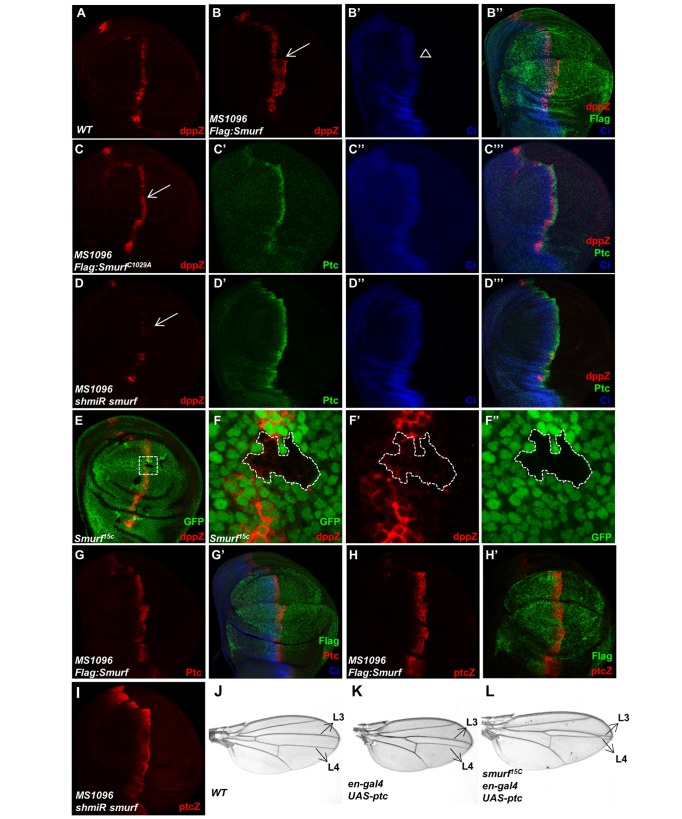
Smurf positively regulates Hh signaling pathway in wing discs.(A) Wild-type (WT) wing discs carrying dpp-LacZ (dppZ) reporter were immunostained with anti-β Gal antibody to show the expression of dppZ (red). (B–B″) Wing discs expressing Flag:Smurf driven by MS1096-gal4 were immunostained to show the expression of dppZ (red), Ci (blue), and Flag (green). (C–C′″) Wing discs expressing Flag:SmurfC1029A driven by MS1096-gal4 were immunostained to show the expression of dppZ (red), Ptc (green), and Ci (blue). (D–D′″) Wing discs expressing shmiR smurf driven by MS1096-gal4 were immunostained to show the expression of dppZ (red), Ptc (green), and Ci (blue). (E and F–F″) Low (E) and high (F–F″) magnification views of a smurf15c clone at A/P boundary. Immunostaining was performed to show the expression of dppZ (red) and GFP (green). Smurf15c clones are recognized by the lack of GFP. (G and G′) Wing discs expressing Flag:Smurf driven by MS1096-gal4 were immunostained with Ptc antibody to show the expression of Ptc (red) and Flag (green). (H and H′) Wing discs expressing Flag:Smurf driven by MS1096-gal4 were immunostained to show the expression of ptcZ (red) and Flag (green). (I) Wing discs expressing shmiR smurf driven by MS1096-gal4 were immunostained to show the expression of ptcZ (red). (J–L) comparison of adult wing phenotype from wild-type flies (J), UAS-ptc overexpression driven by en-gal4 (K), and UAS-ptc overexpression driven by en-gal4 in smurf15C homozygous background (L).